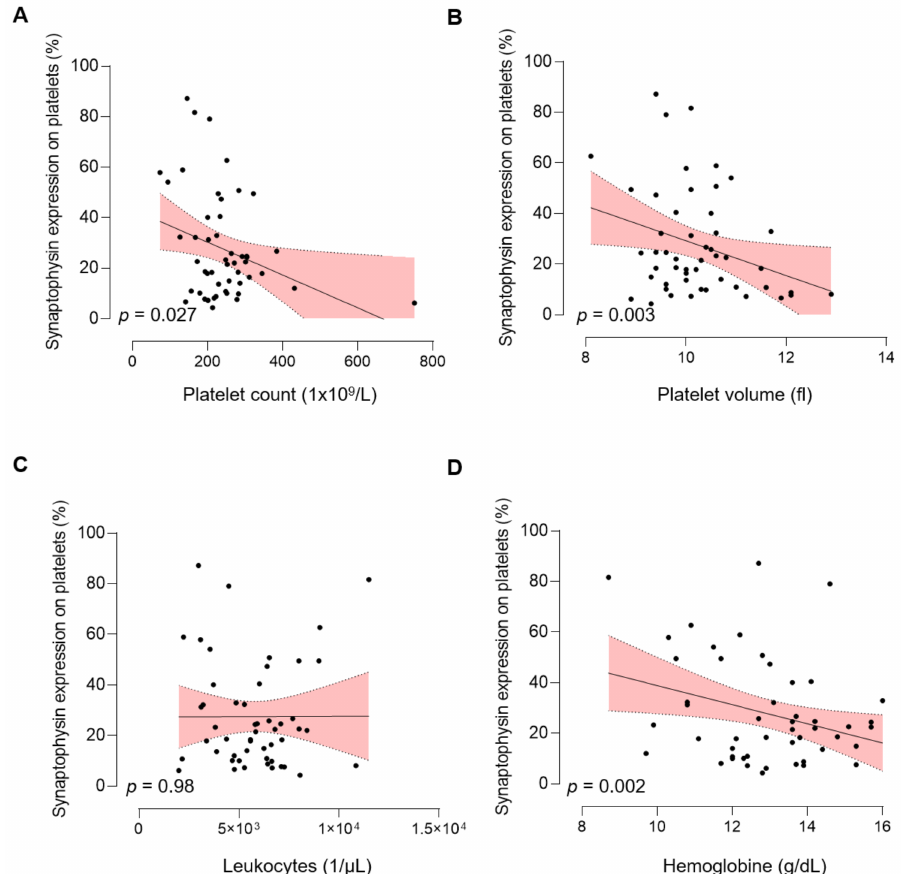
Figure 3. Association of pSyn with hematological parameters. ( A ) Correlation of pSyn expression and platelet count, platelet volume ( B ), leukocyte count ( C ), and hemoglobin concentration ( D ). Line indicates linear regression, gray area 95% CI